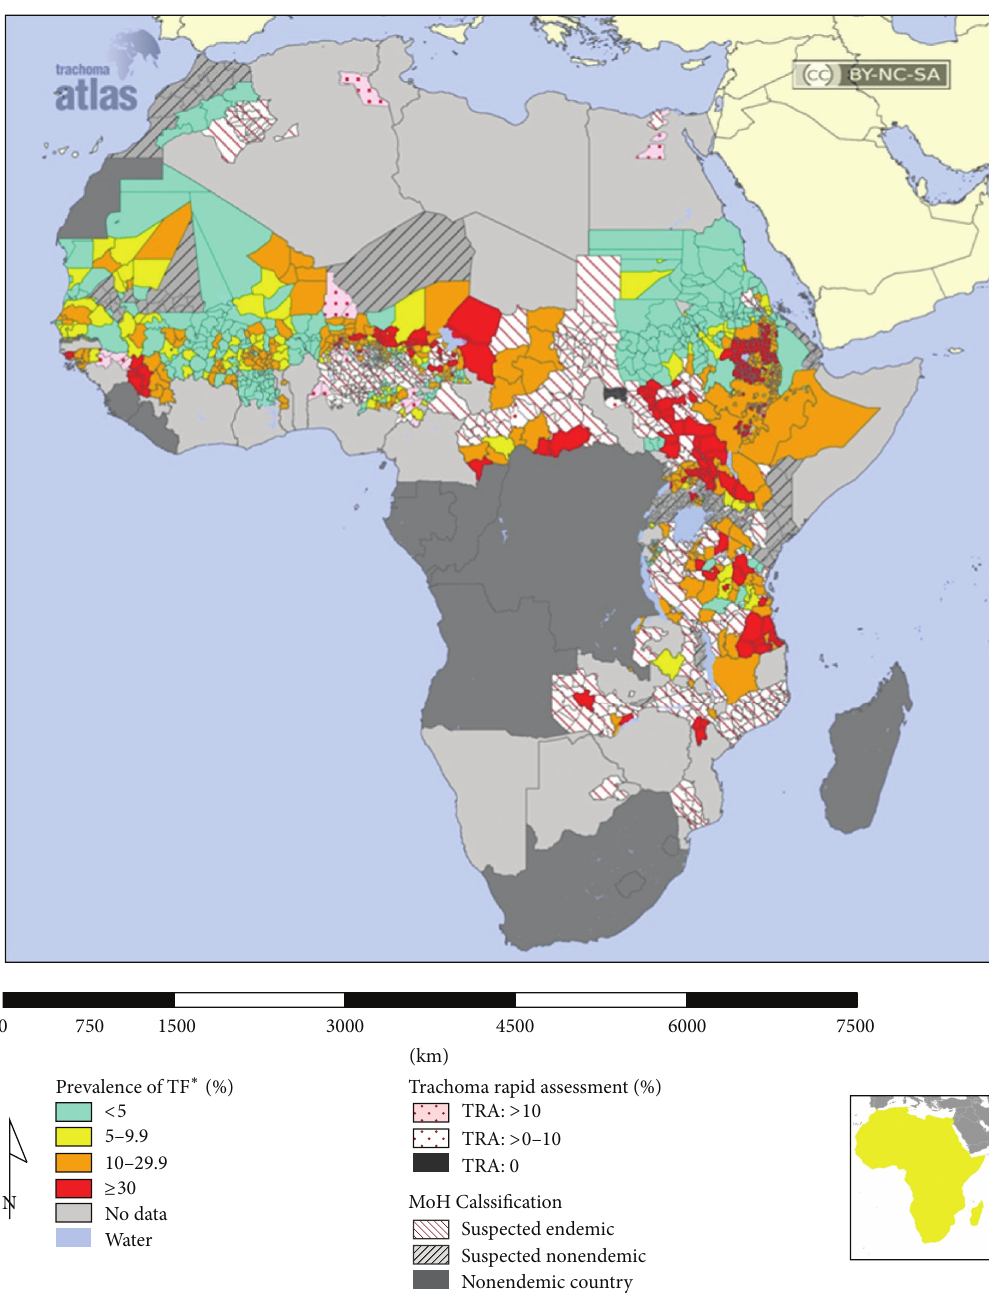
Figure 3: Prevalence of trachoma in Africa using trachoma follicular as clinical indicator. Figure courtesy of Trachoma Atlas [7].